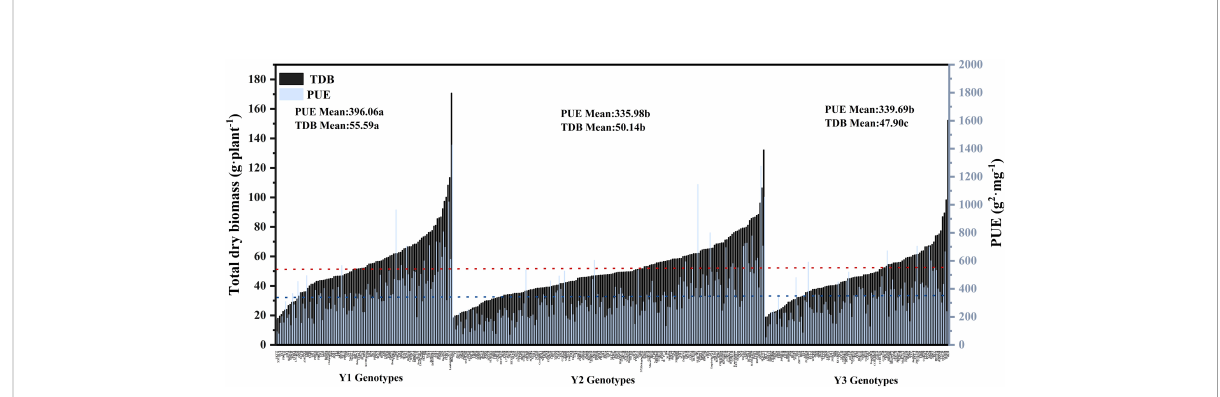
signi fi cant connections for most of these traits (Figure 7). Among these traits, except for RTD and SRTD, there is a positive correlation between each root trait (Figure 7). There were signi fi cant negative correlations between RTD, RSA, and RVE, with correlation coef fi cients of -0.29 and -0.53, respectively, and a similar trend existed with SRL (Figure 7; Supplementary Table S5). In addition, except for SRA, SRTD, and SRL, root traits have positive correlations with SDB, but